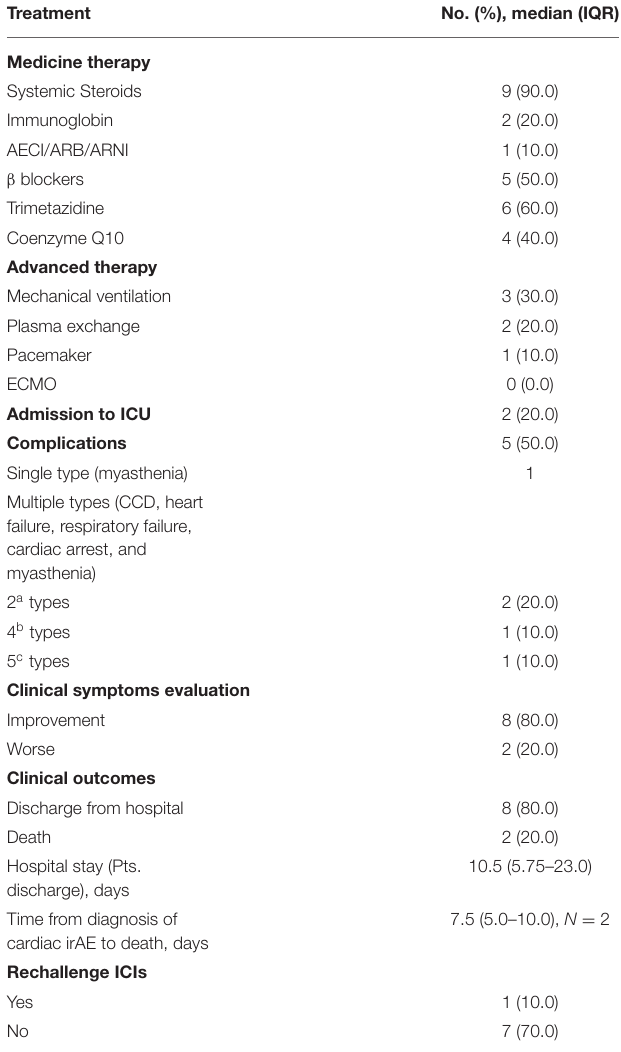
TABLE 3 | Treatment and clinical outcome of the patients with cardiac irAE.